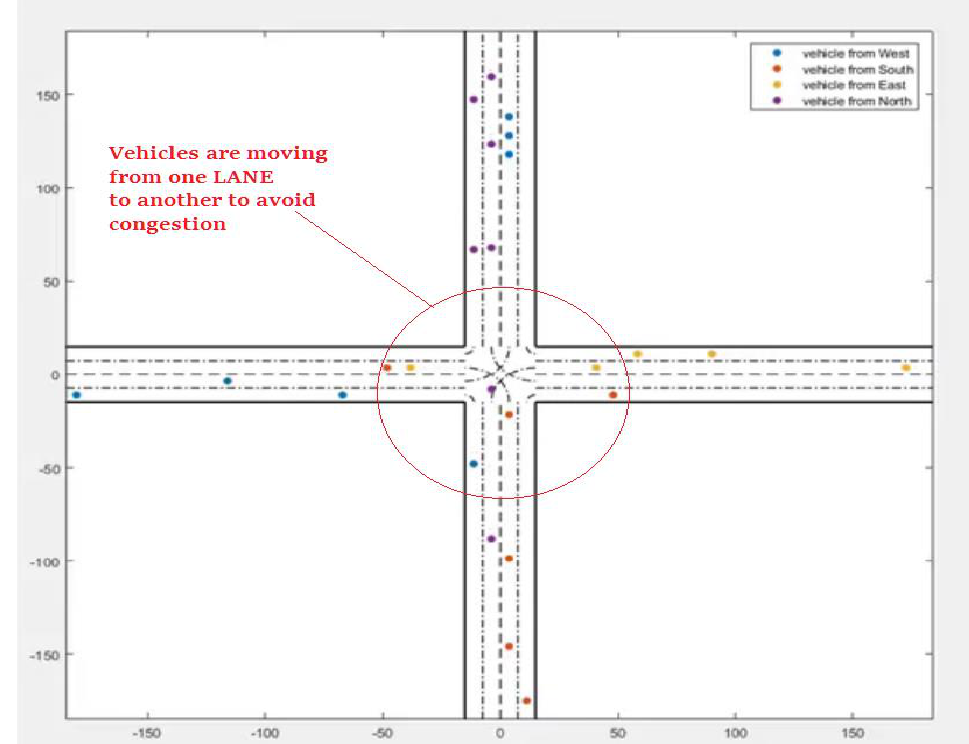
Figure 11. Vehicle movement based on signals received from RSUs.